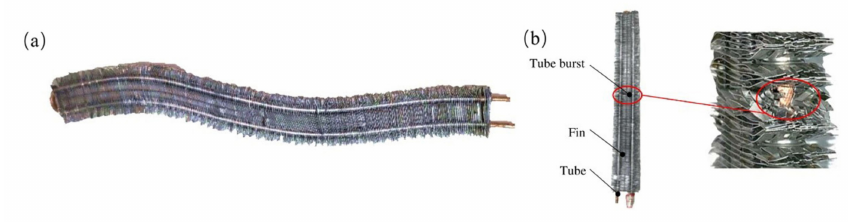
Figure 6. ( a ) Bending failure and ( b ) bursting failure in the sample due to hydraulic expansion.